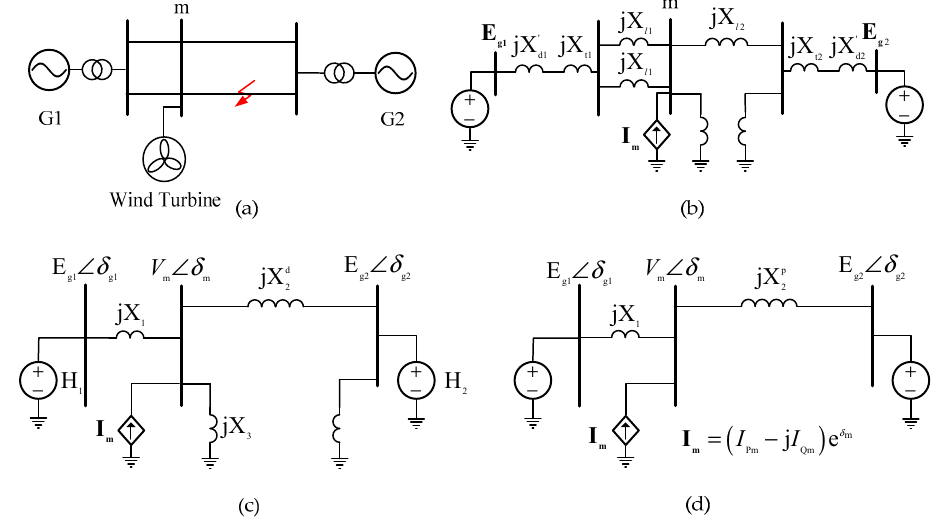
Figure 4. Schematic diagrams: ( a ) a two synchronous machine, one aggregated wind turbine system, ( b ) its equivalent circuit during fault, and ( c , d ) the concise equivalent circuits during and post fault, respectively.